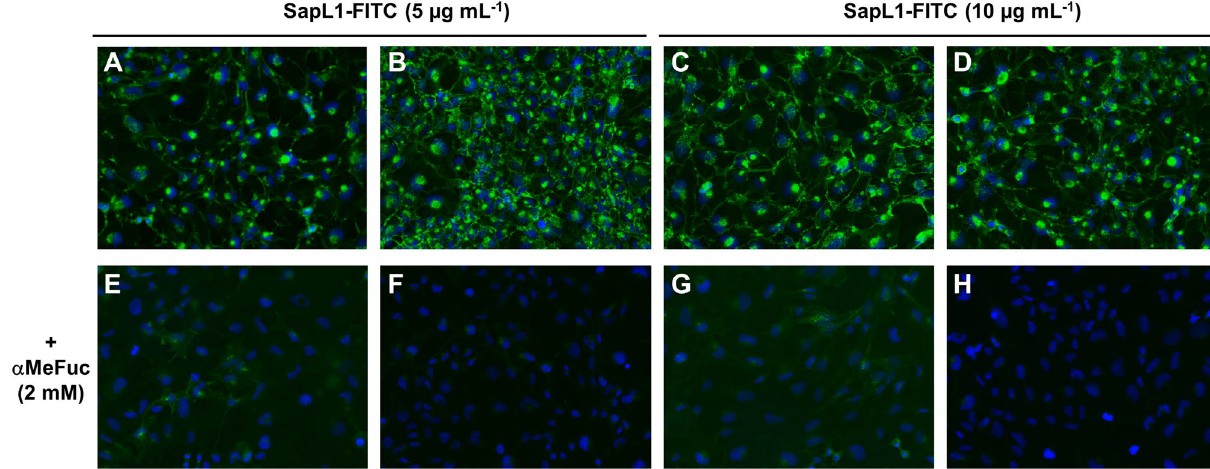
Figure 7. Interaction of Scedosporium apiospermum lectin SapL1 with bronchial epithelial cells. ( A – D ) Representative microscopic images of bronchial epithelial cells (BEAS-2B cell line) treated with SapL1-FITC (green) (5 (A,B) or 10 (C,D) µg mL −1 ) for 1 h. ( E – H ) Representative microscopic images of bronchial epithelial treated for 1 h with SapL1-FITC (green) (5 ( E , F ) or 10 ( G , H ) µg mL −1 ) previously preincubated 30 min with 2 mM methyl-α-L-fucopyranoside (αMeFuc). Nuclei were labelled with 4 ′ -6-diamidino-2-phenylindole dihydrochloride (DAPI, blue). Cells were visualized with an Olympus BX43 microscope (magnification ×